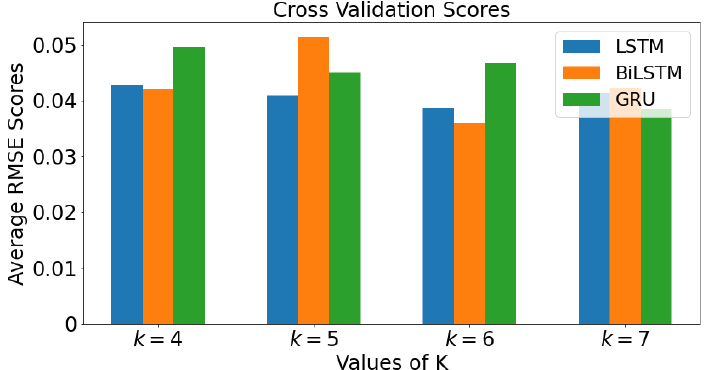
Figure 17. Cross Validation Scores using mean scores for each value of k for real COVID-19